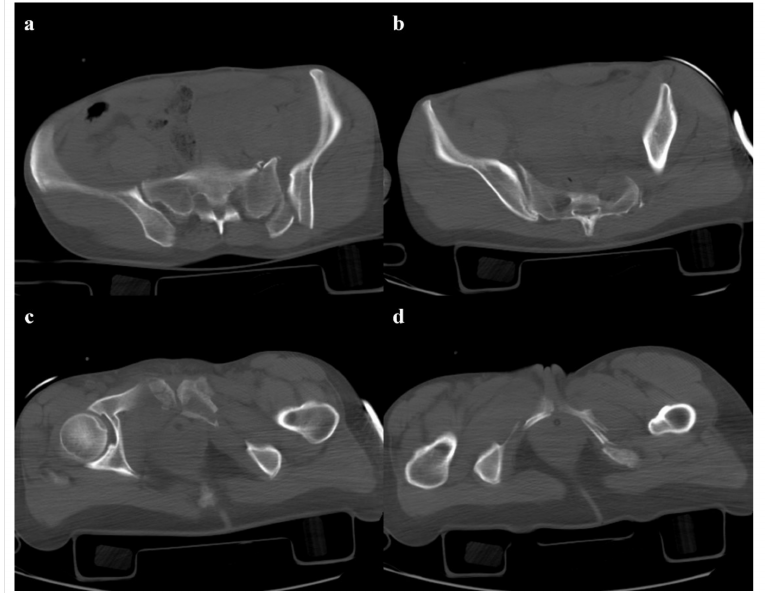
Figure 3. Lateral compression fracture, type 3. Axial CT images show the fracture of the iliac and sacral wings on the left side ( a ), anterior widening of the right sacroiliac joint ( b ), and fracture of bilateral pubic branches ( c , d